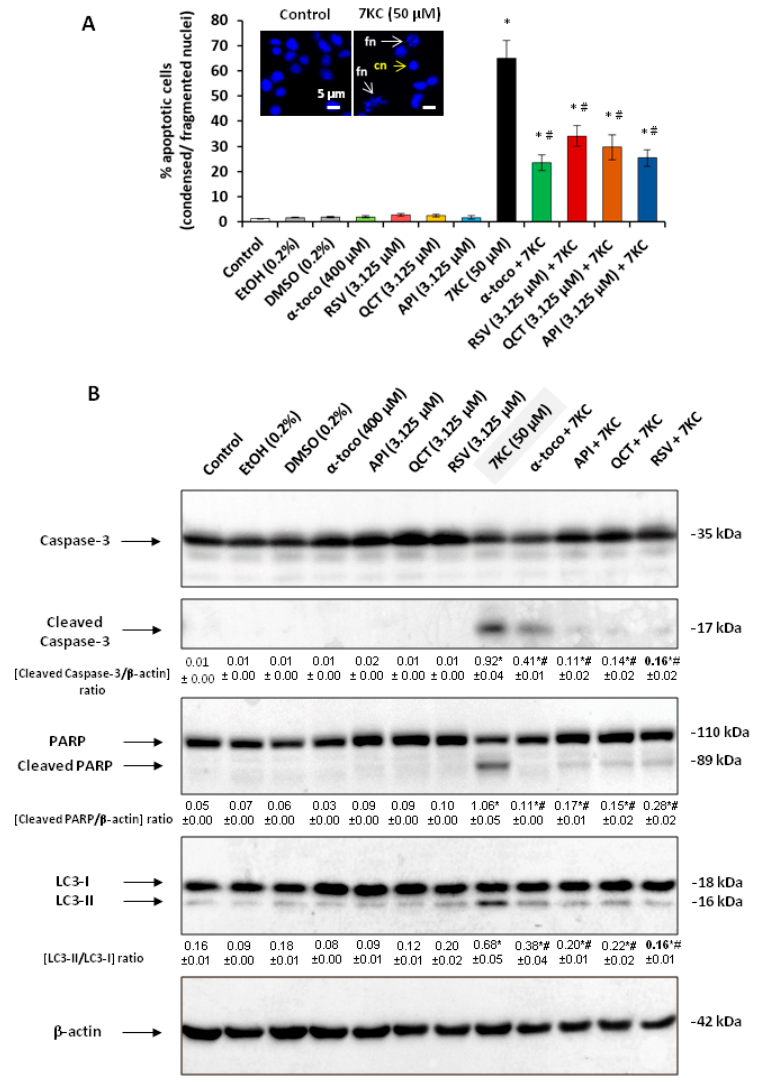
Figure 11. Effect of resveratrol, quercetin, apigenin and α -tocopherol on 7KC-induced autophagy and apoptosis: characterization of apoptotic nuclei by staining with Hoechst 33342, identification of